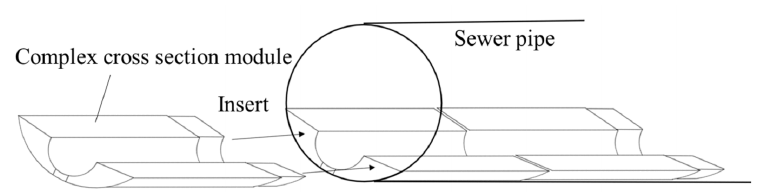
Figure 1. Schematics of the installation of complex cross-section modules in a sewer